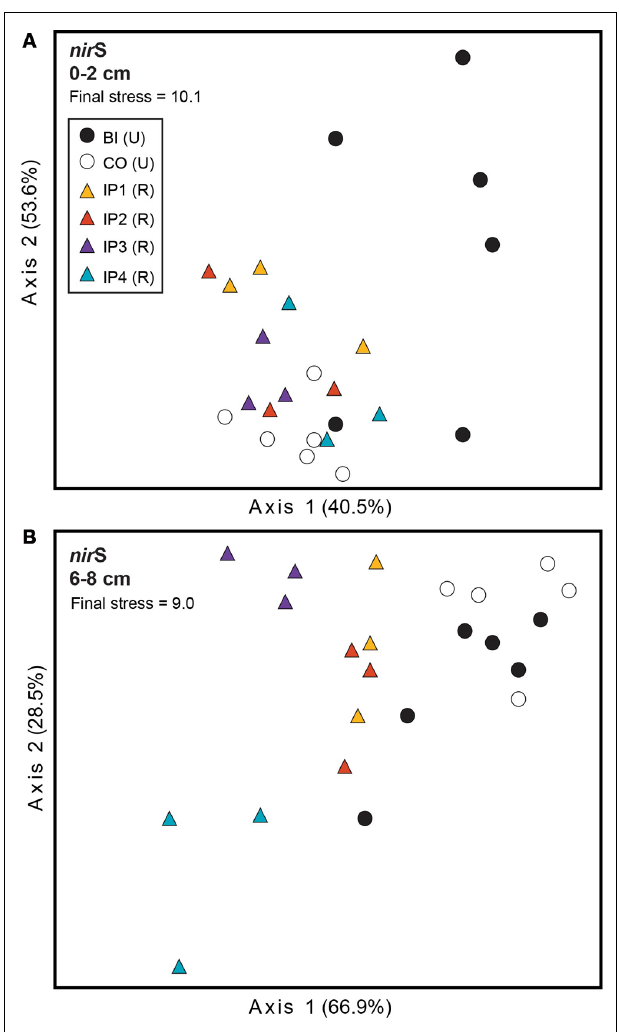
FIGURE 3 | Non-metric multidimensional scaling plot ofTRFLP profiles for archaeal amo A genes in surface (A) and deep (B) sediments. Percent variability explained by each axis is shown parenthetically on the axis labels. In both panels, triangles represent restored (R) marshes (IP 1–4); cirlces represent undisturbed (U) marshes from Barn Island (BI) or Cottrell (CO)